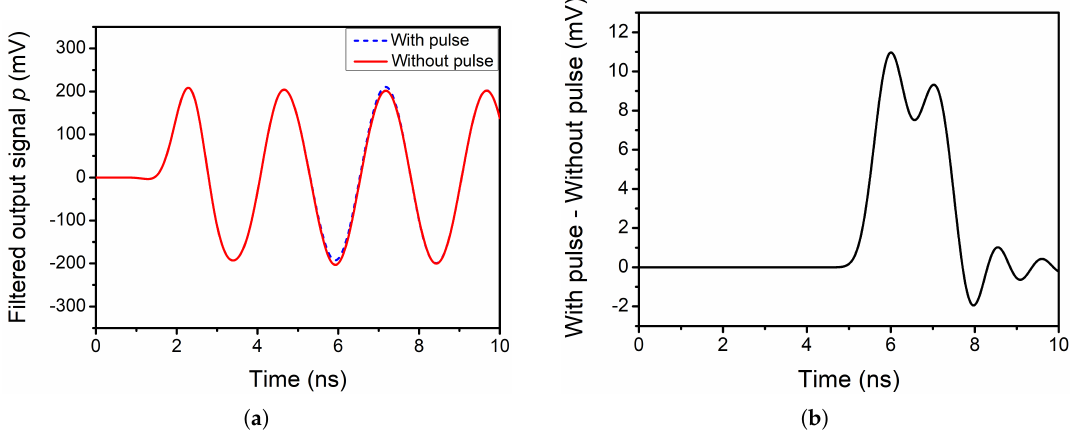
Figure 6. ( a ) Filtered single-ended output of the double-balanced mixer when there is a pulse at the input ( τ = 2 ns) and when there is no pulse. ( b ) Effect of the pulse on filtered single-ended output ( τ = 2